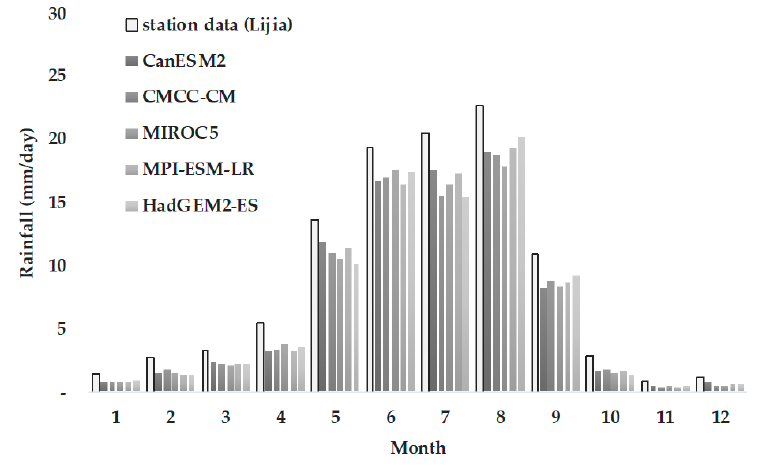
Figure 9. Bias correction result in rainfall of the Fixed-Threshold method.